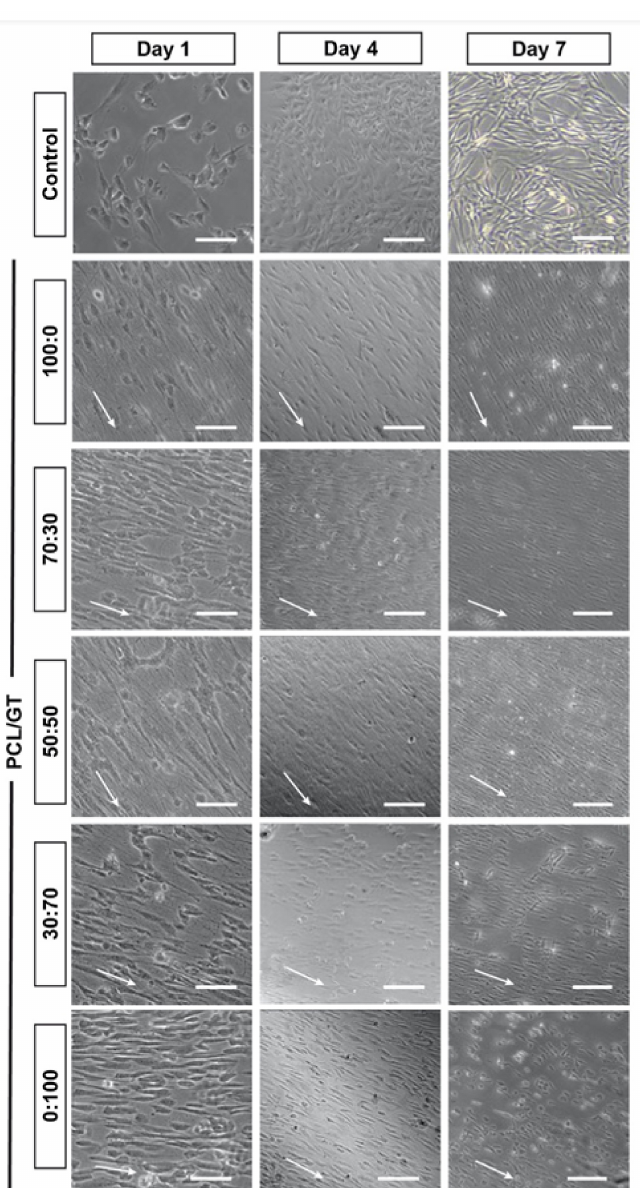
Figure 6. The alignment of WJ-MSCs on PCL/GT nanofibers. Note that WJ-MSCs on PCL/GT 0:100 started to lose their orientation as the nanofibers were degraded following days in culture. (Scale bar represents 100 µ m, arrow indicates the direction of cell